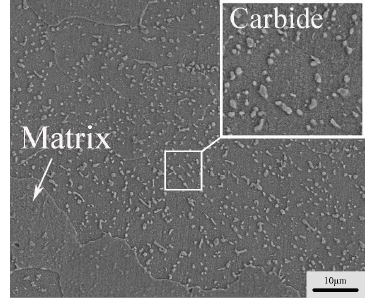
Figure 5. Non-stretched SEM images of H13 steel.